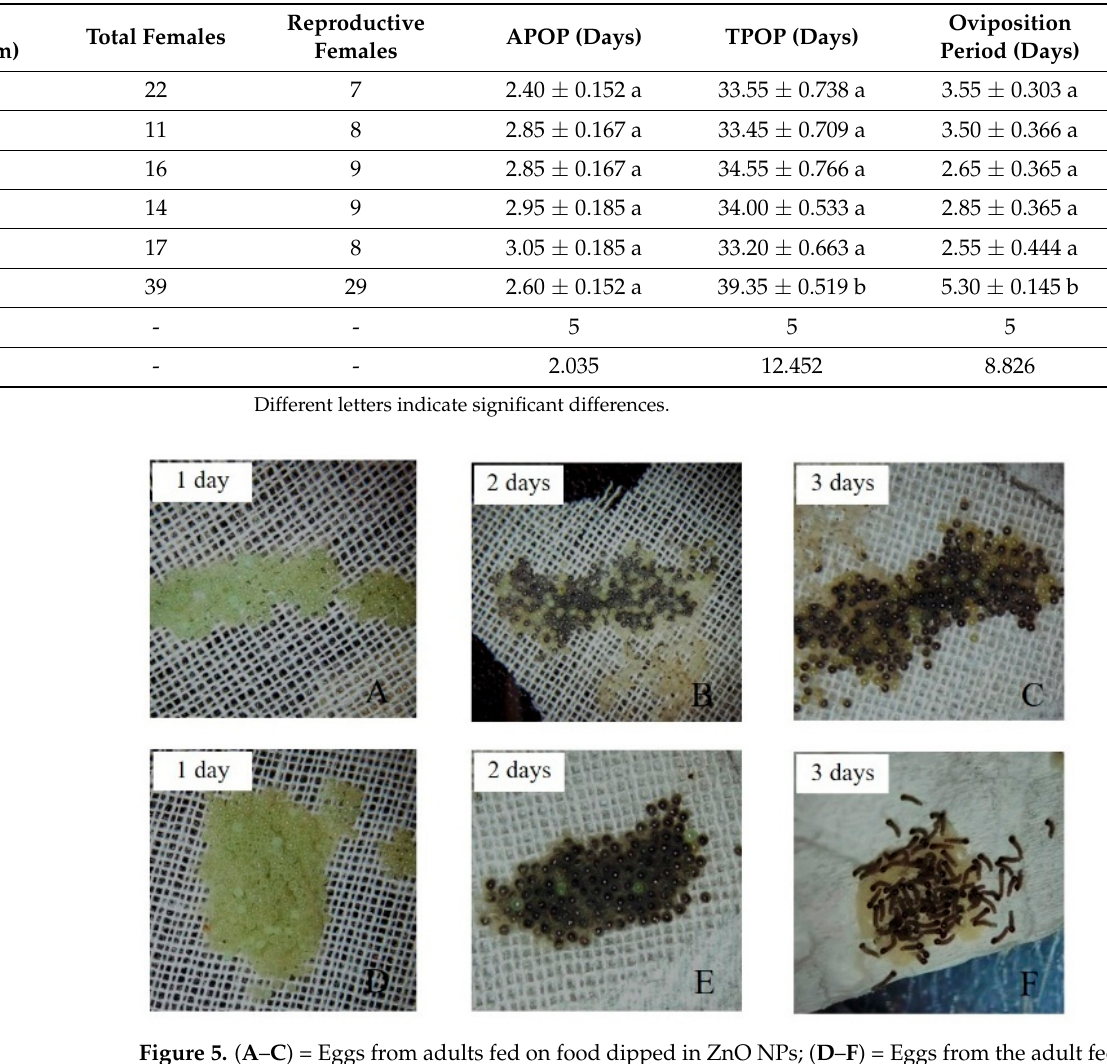
Figure 5. ( A – C ) = Eggs from adults fed on food dipped in ZnO NPs; ( D – F ) = Eggs from the adult fed on food dipped in control. Table 4. Adult preoviposition period (APOP), total preoviposition period (TPOP), oviposition pe- riod, fecundity, and percent hatching parameters.